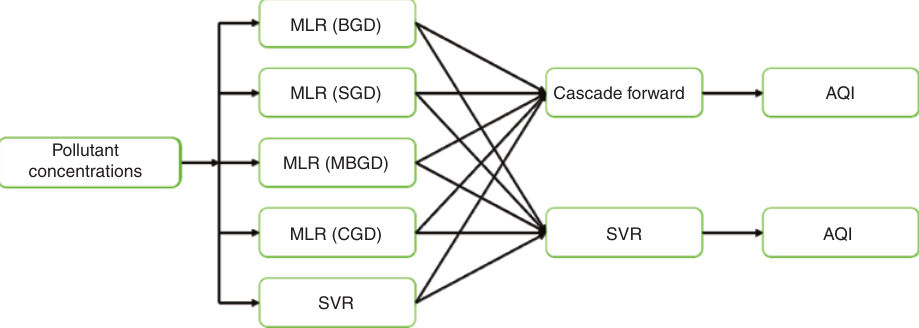
Figure 2: Cascade Forward and SVR Ensemble of MLR with Gradient Descent Variants and SVR.